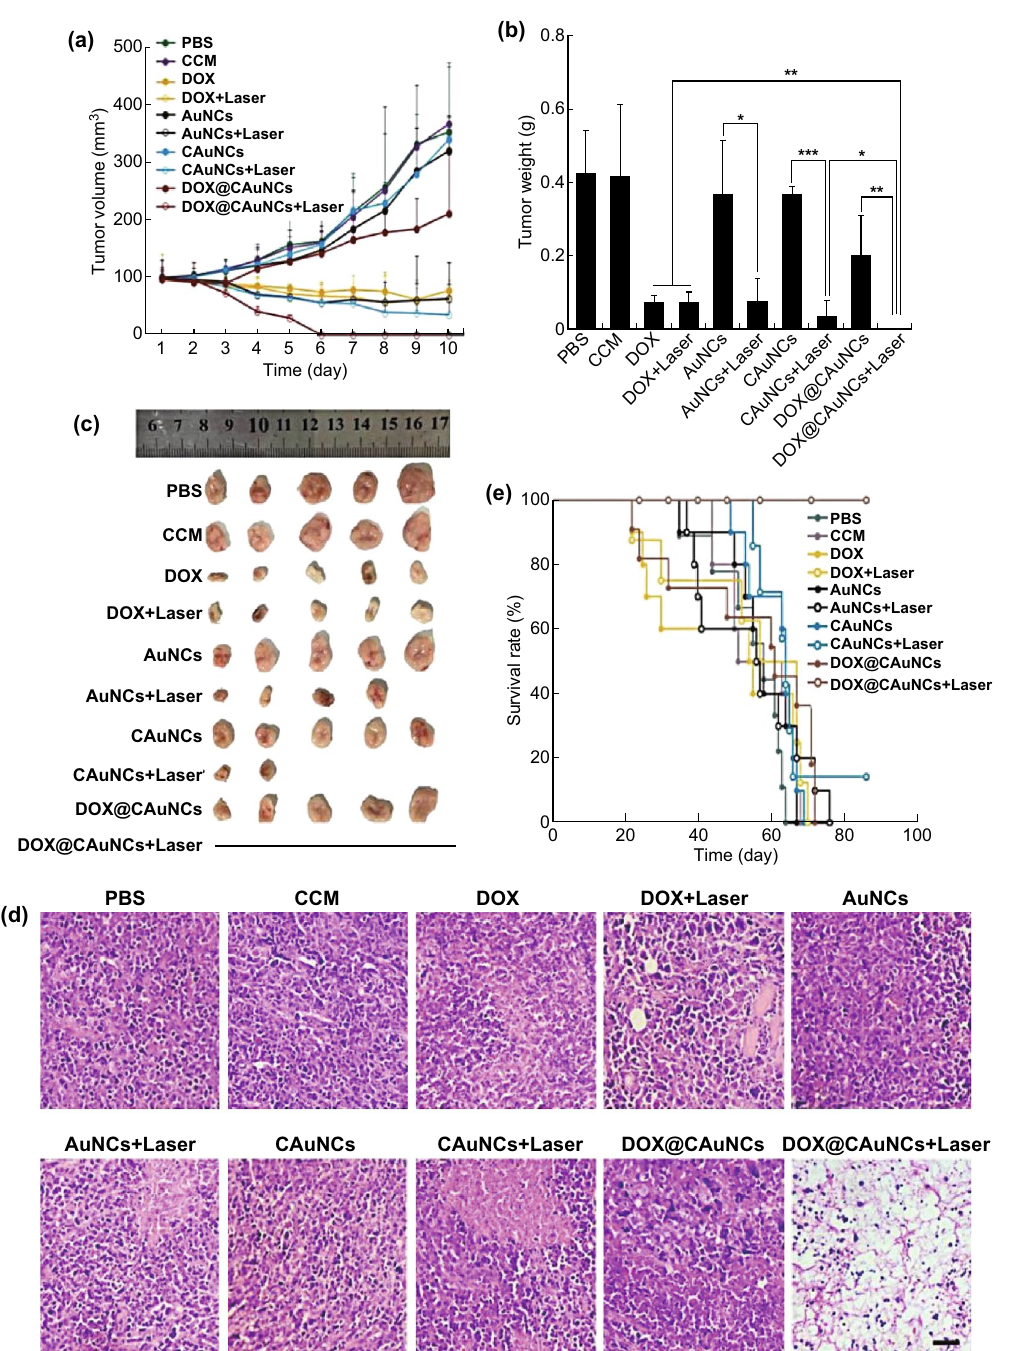
Fig. 14 DOX‑loaded CAuNCs mediate synergistic PTT and chemotherapy. a H22 tumor growth in mice following treatment with the indicated Au/DOX doses (10 and 15 mg kg −1 ) with or without irradiation (10 min; 808 nm; 1 W cm −2 ) once daily for 4 days ( n = 13). B Tumor weight after treatment ( n = 5). c Photos of tumors after treatment. d H&E stained tumor sections from mice treated as in a . Scale bar = 50 μm. e Kaplan– Meier survival curve for mice treated as in a ( n = 8). Data are mean ± SD, * p < 0.05, ** p < 0.01, *** p < 0.001. Adapted from Ref. [40] with per‑